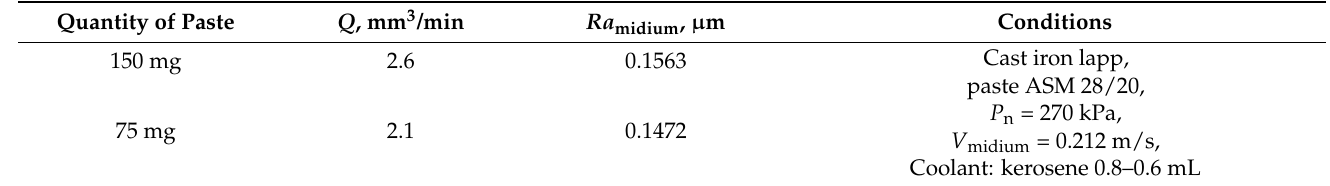
Table 4. The effect of the amount of diamond paste on the productivity and roughness of the treated surface.